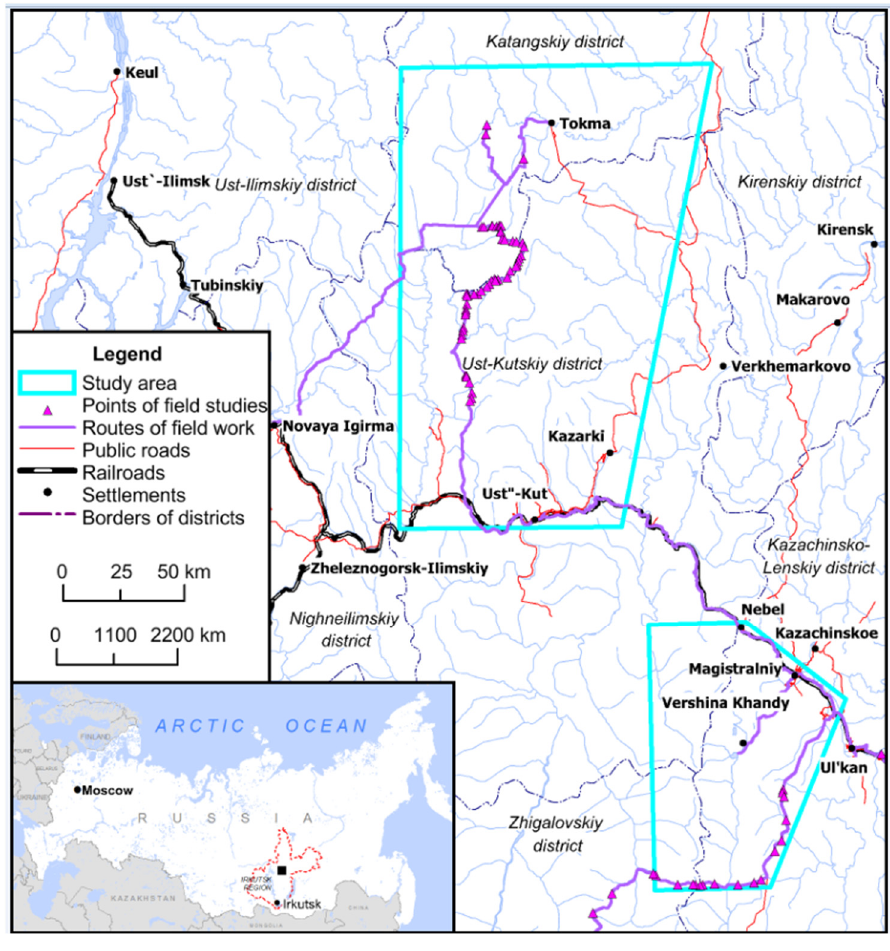
Figure 1. The study areas.